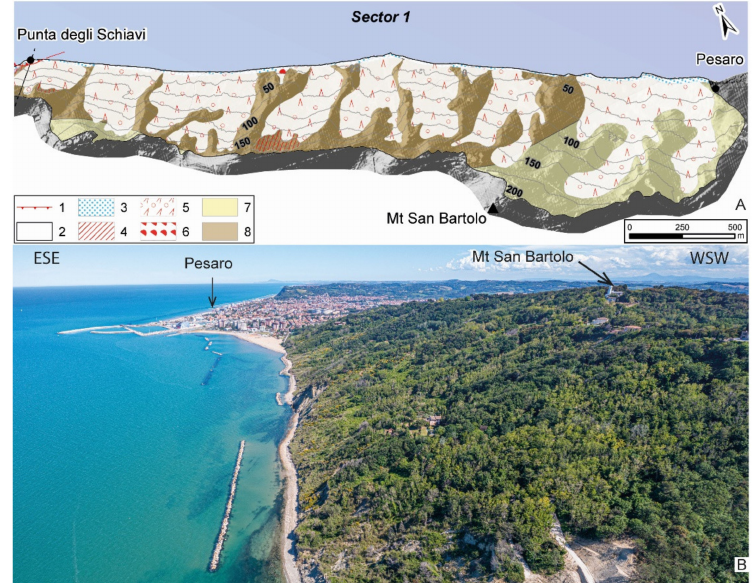
Figure 2. Sector 1 (Pesaro–Punta degli Schiavi) of the Mt. San Bartolo coastal slope. ( A ) Detailed geomorphological map: 1, Thrust fault; 2: Sector border; 3, Beach; 4, Landslide scarp; 5, Slide; 6, Flow; 7, Colombacci Formation; 8, San Donato Formation. ( B ) Panoramic view toward the south.